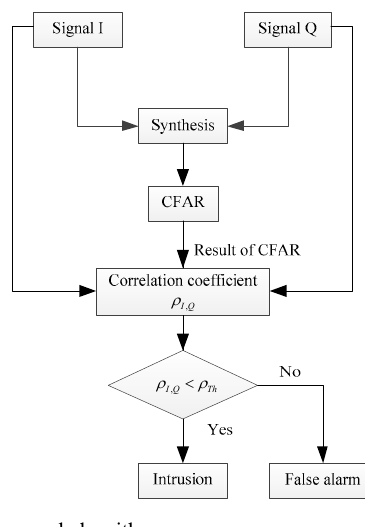
Fig. 8 Proposed algorithm.